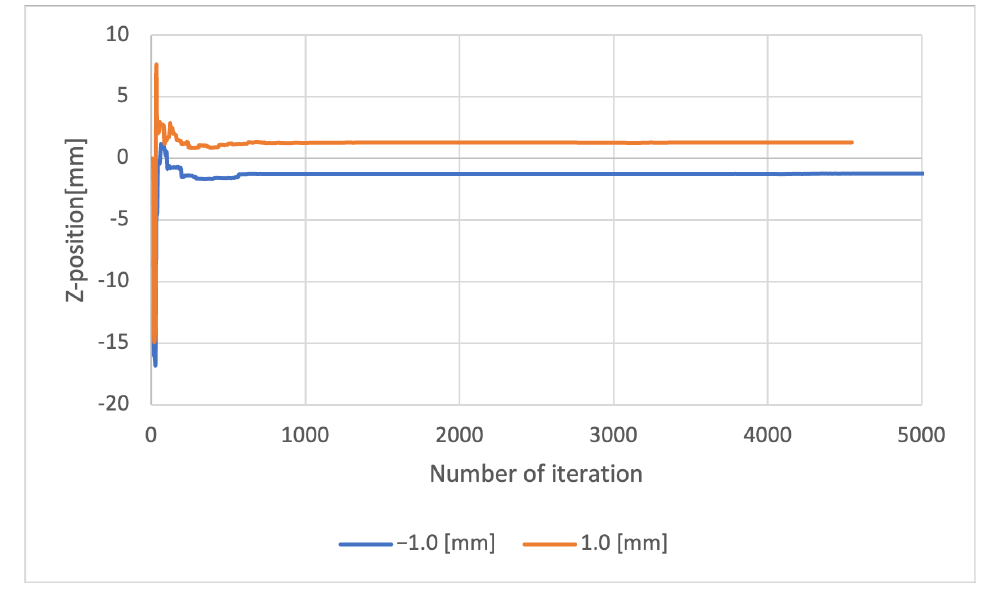
Figure 12. Convergence of iterative calculation of z -axis displacement in Method